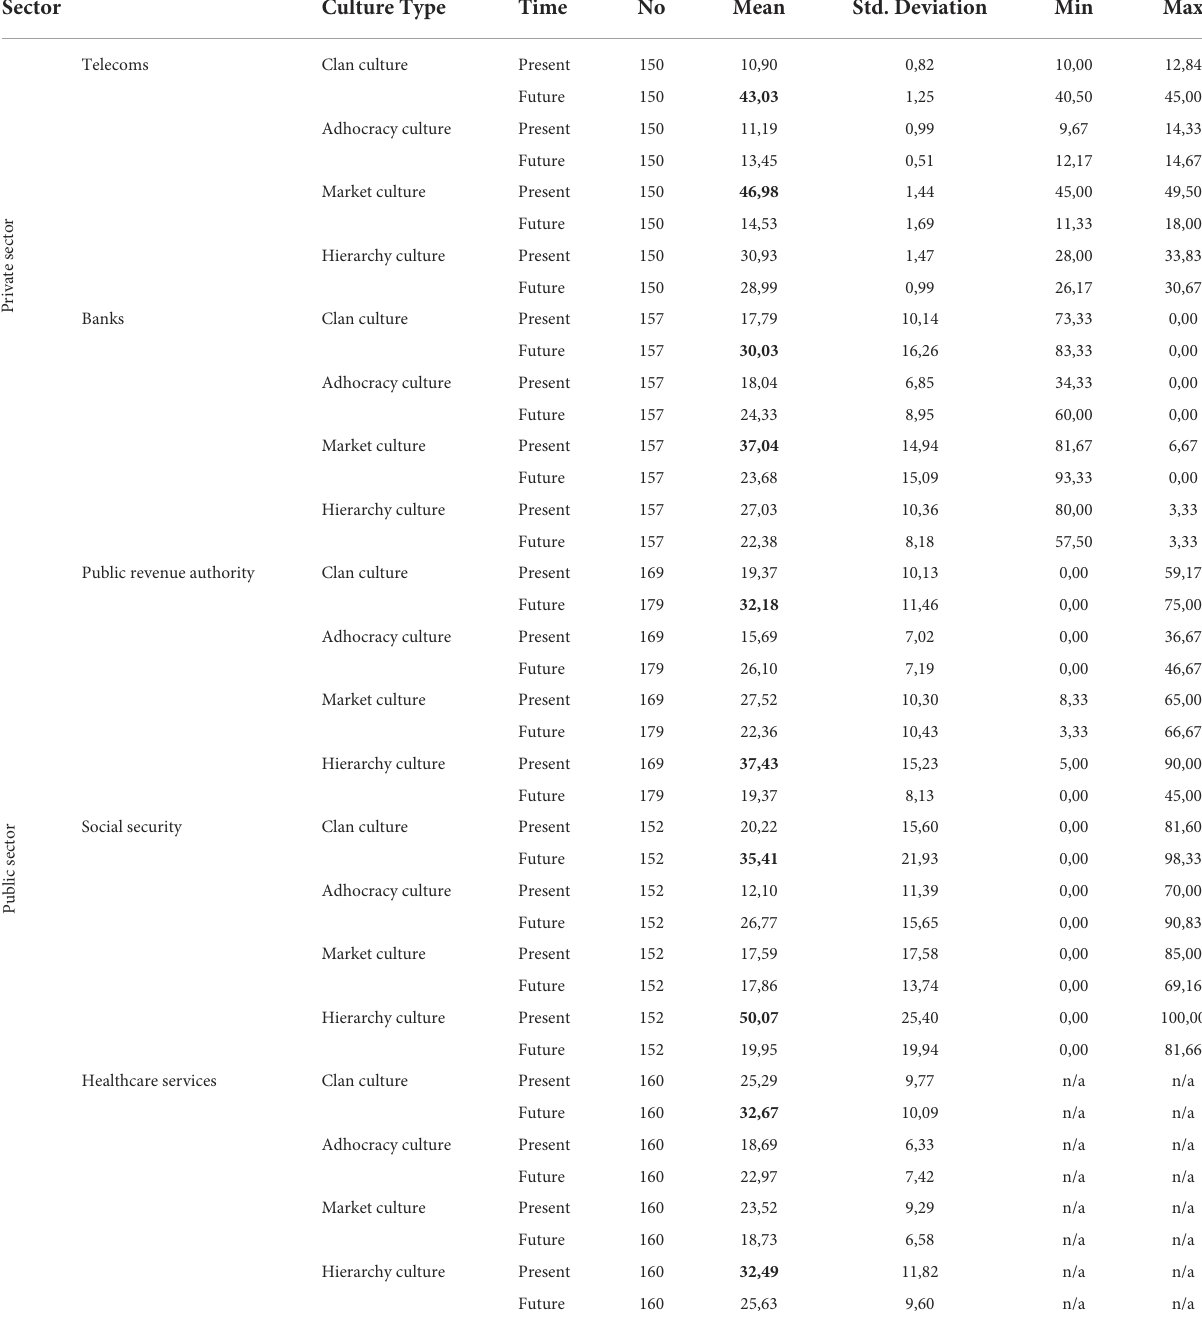
TABLE 3 Descriptive statistics of the surveys